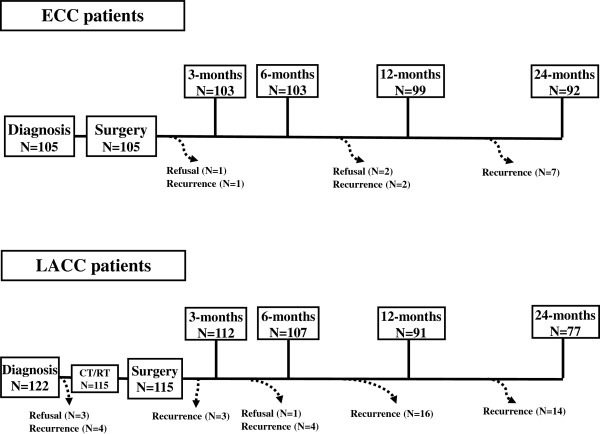
Time line of questionnaire administration, and flow chart of our patient population.